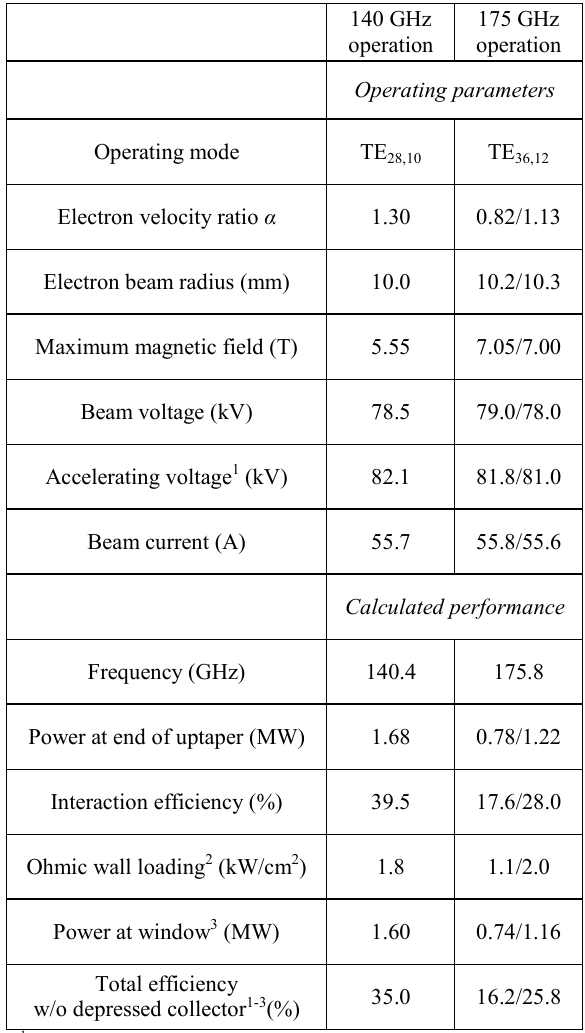
Table 2. Operating parameters and calculated performance of the upgraded W7-X gyrotron.